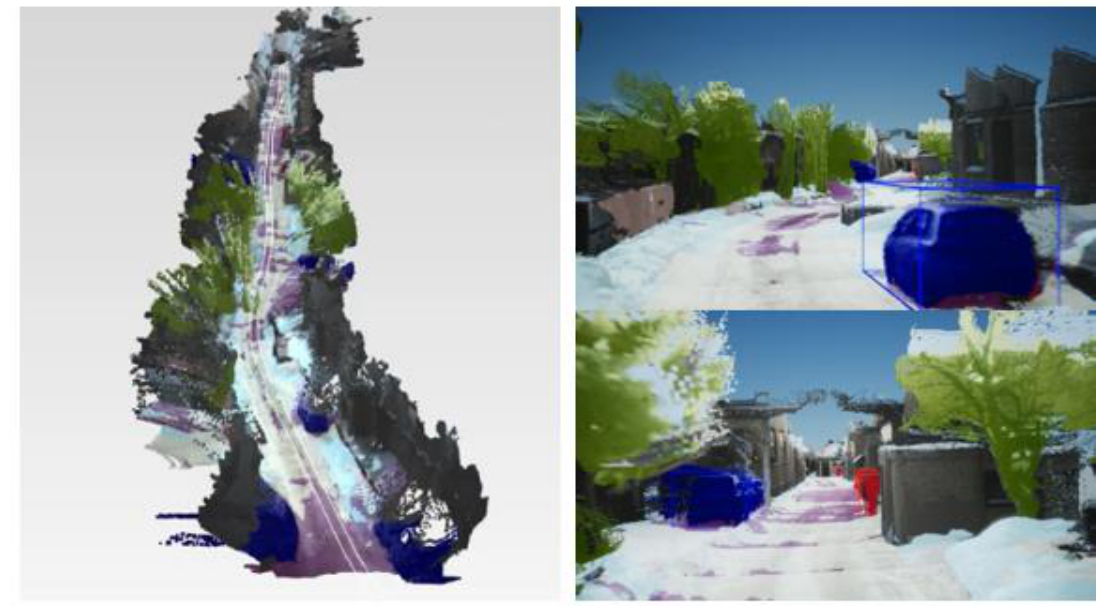
Figure 8 . Visual odometry and 3D semantic